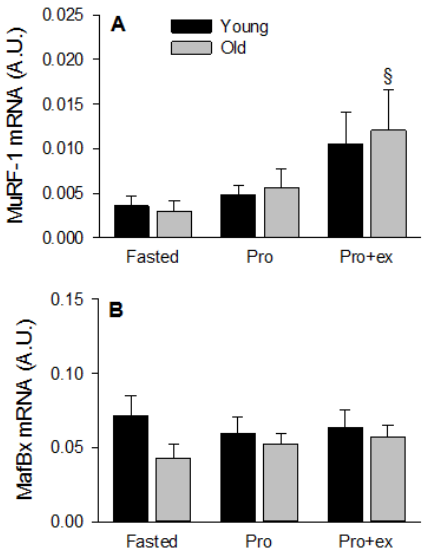
Figure 4. Effect of aging on markers for the proteasome-ubiquitin system after resistance exercise and protein intake. ( A ) MuRF-1 and ( B ) MafBx mRNA levels in Fasted, Pro, and Pro+ex conditions in young and older subjects. Values are means ± SEM. § p < 0.05 vs. fasted same age.